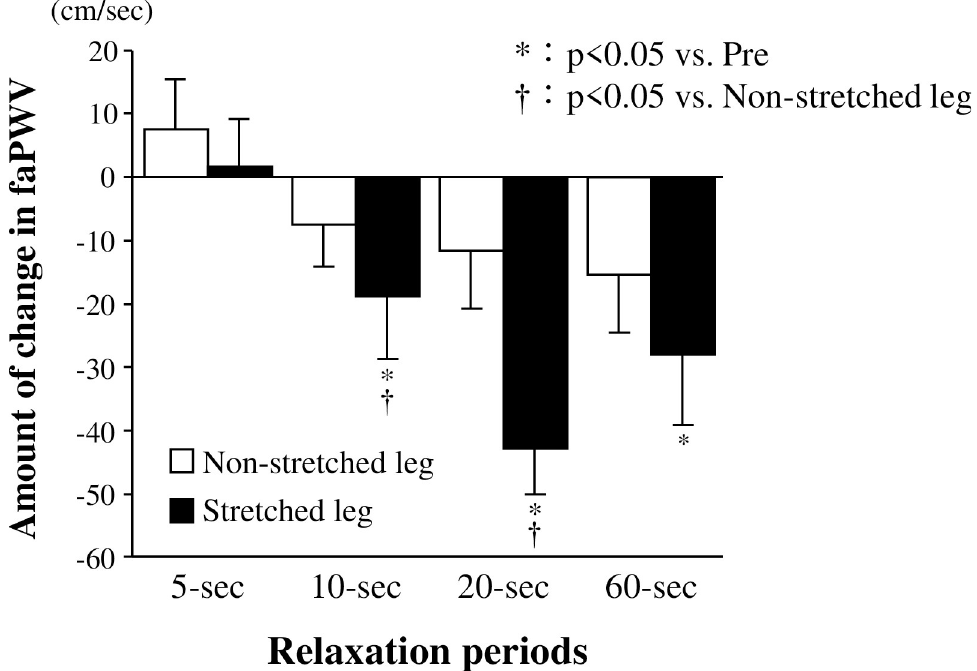
Fig 5. Amount of change in faPWV before and after passive one-legged calf stretching. 5-s, condition of 5-s relaxation; 10-s, condition of 10-s relaxation; 20-s, condition of 20-s relaxation; 60-s, condition of 60-s relaxation; faPWV, femoral-ankle pulse wave velocity; � P < 0.05 vs. 5-s, † P < 0.05 vs. Non-stretched leg. Data are presented as mean ± SE.